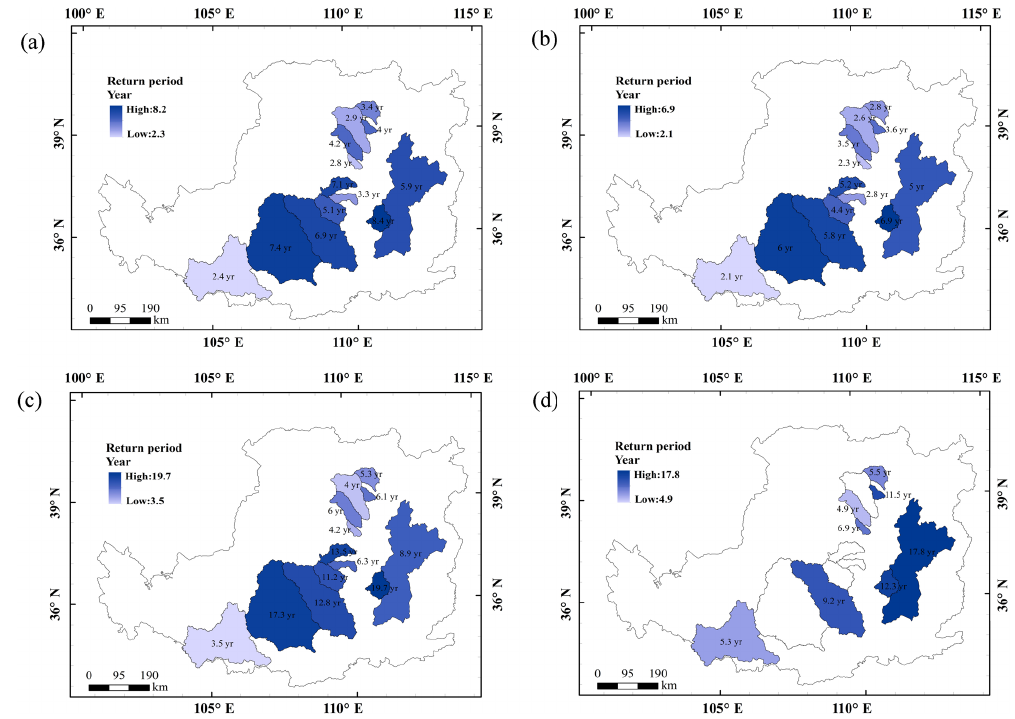
Figure 7. Spatial distribution of the return period of drought events in watersheds: (a) spatial distribution of the return period of drought events in 1970–1974; (b) spatial distribution of the return period of drought events in 1979–1983; (c) spatial distribution of the return period of drought events in 1991–1999; (d) return period of drought events corresponding to watersheds with significant changes in the PRR.